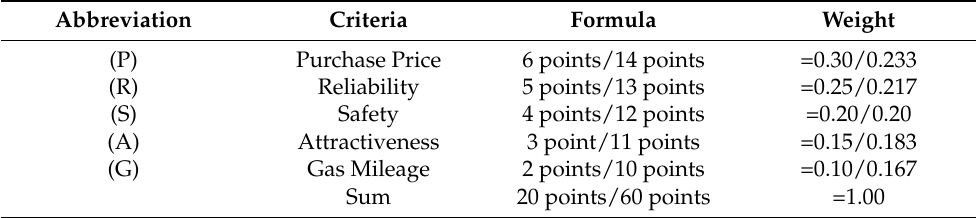
Table 11. Weighs for pairwise method using